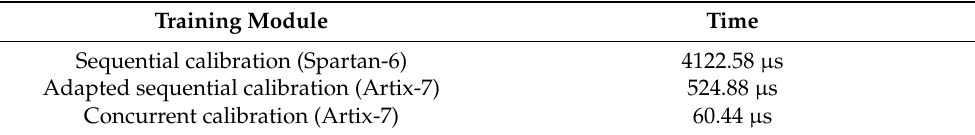
Table 2. Calibration times for the GSENSE400 image